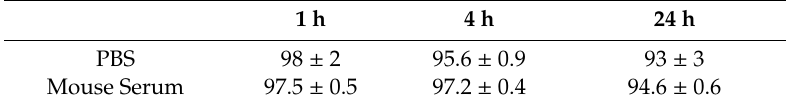
Table 2. Stability of [ 55 Co]Co-rf42 in PBS and mouse serum a.